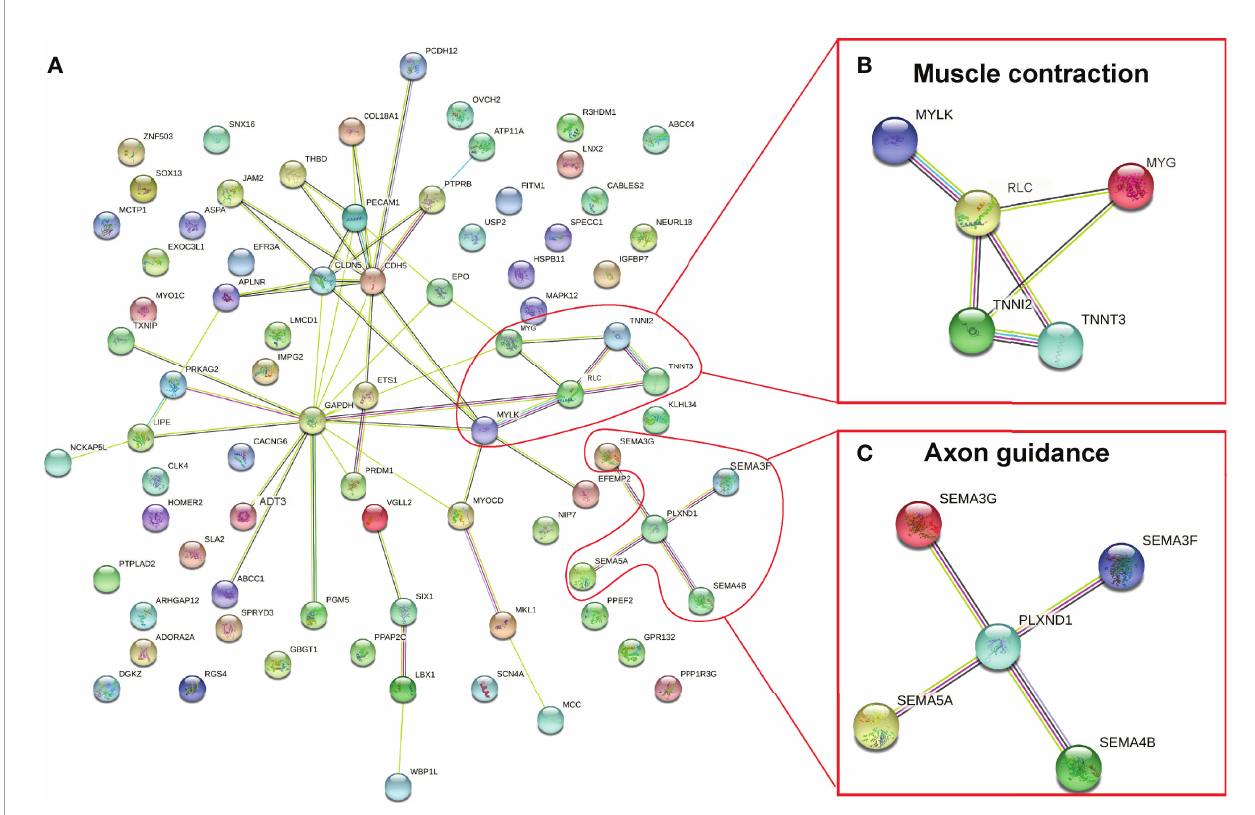
FIGURE 4 | Co-regulation network of DEGs and DMGs between slow- and fast-twitch muscles of P. dentex (A) . Enriched muscle contraction (B) and axon guidance (C) networks. The network nodes indicate proteins, and lines represent there are predicted associations between these two